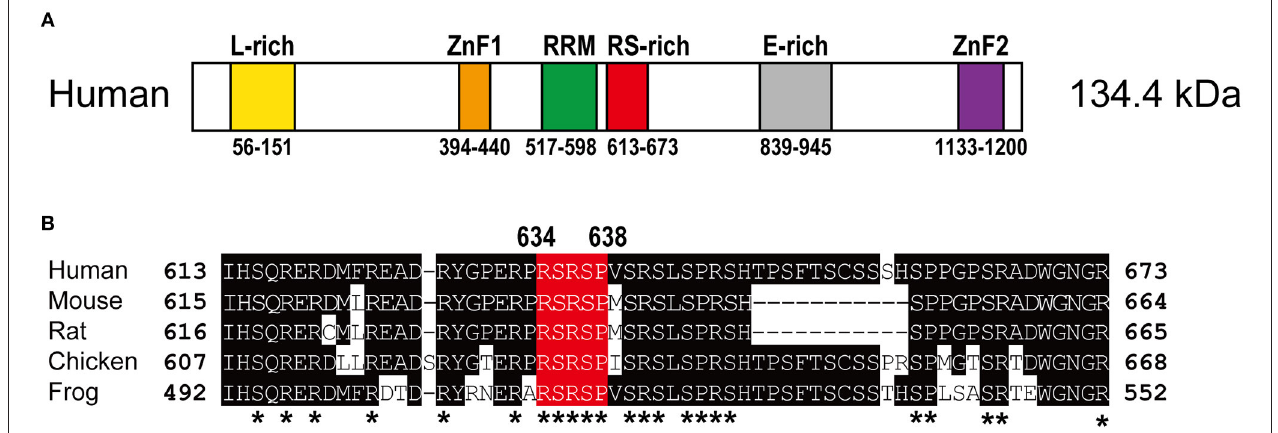
FIGURE 1 | Structure of the RBM20 protein. (A) Schematic domain structure of the human RBM20 protein. Names and positions of the domains are indicated. E-rich, glutamate-rich region; L-rich, leucine-rich region; RRM, RNA-recognition motif domain; RS-rich, arginine/serine-rich region; ZnF, zinc finger domains. (B) Amino acid sequence alignment of the RS-rich region of RBM20 proteins from human, mouse, rat, chicken and frog. Amino acid residues that match the human RBM20 residues are shaded. The RSRSP stretch is in red. Asterisks indicate evolutionarily conserved arginine (R), serine (S), and proline (P)